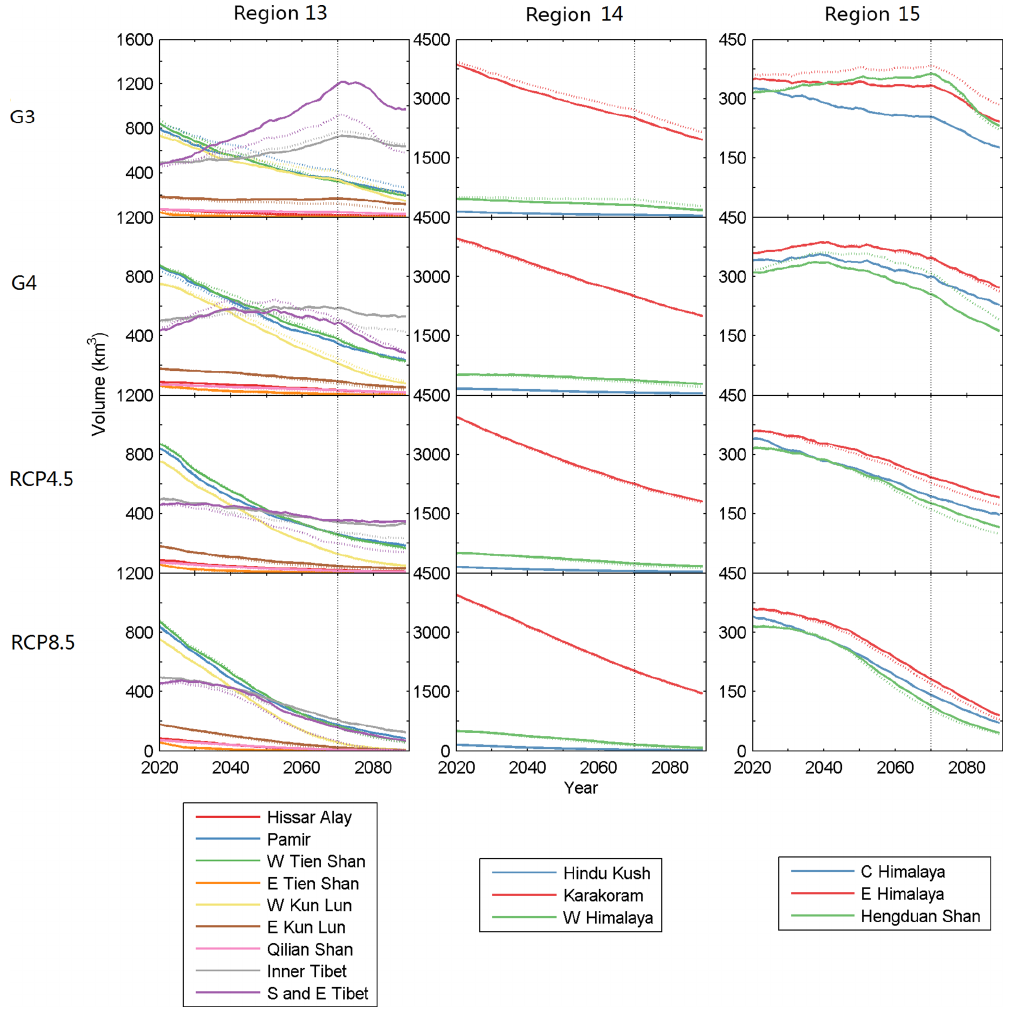
Figure 7. As that for Fig. 5 but for glacier volume (unit: km 3 ). The solid curves are means of individual climate-model-forced simulations. The dashed curves are results using multi-model ensemble mean temperature and precipitation forcing under each